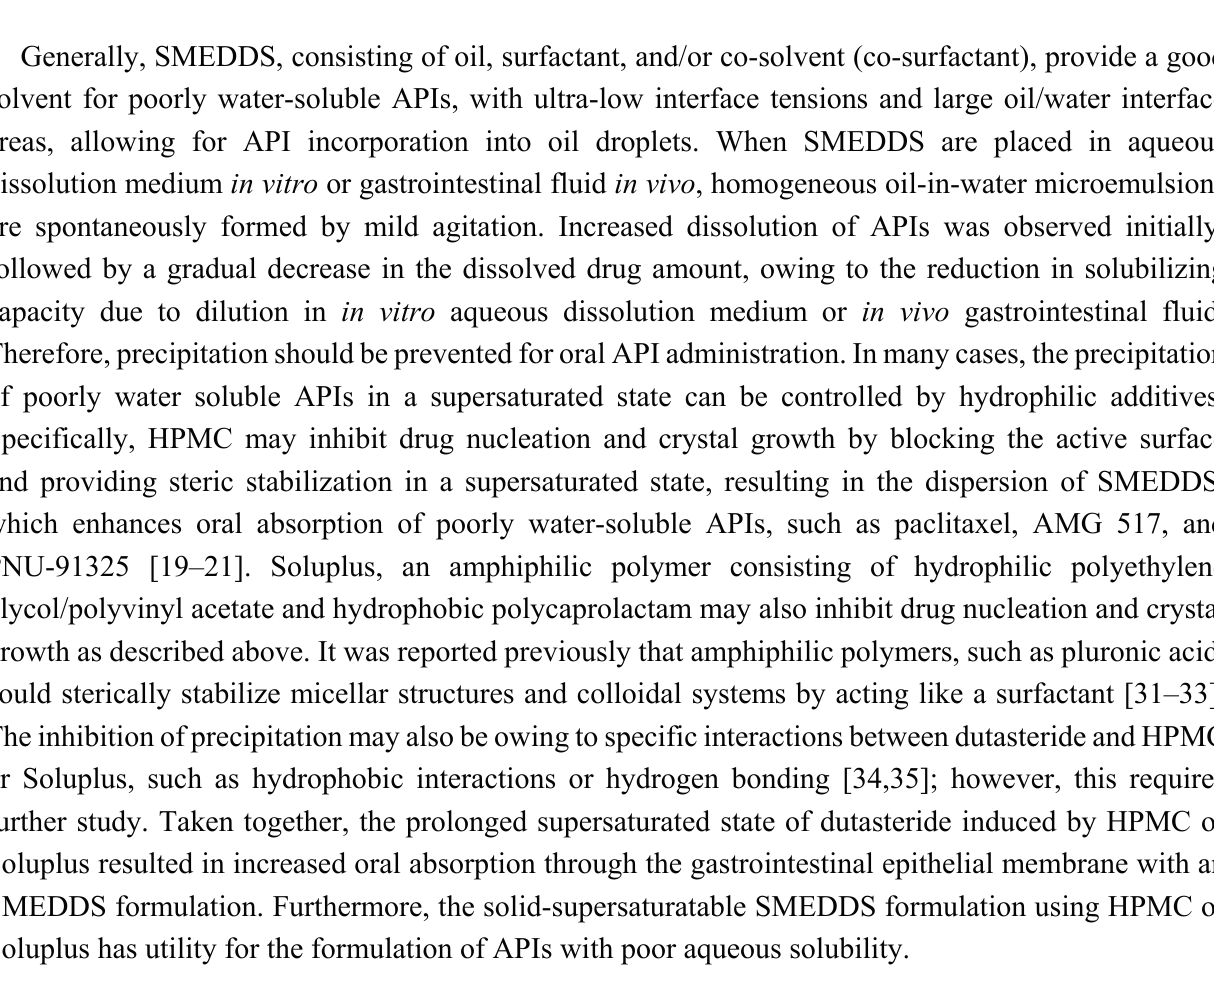
Figure 7. Dissolution profiles of the solid SMEDDS/Aerosil 200/Soluplus at pH 1.2 after 2 months under long-term conditions. Data are expressed as the mean ± standard deviation ( n =